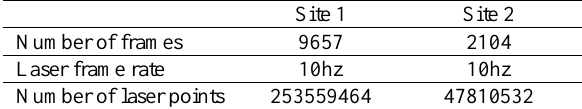
Table 1. Dataset specifications